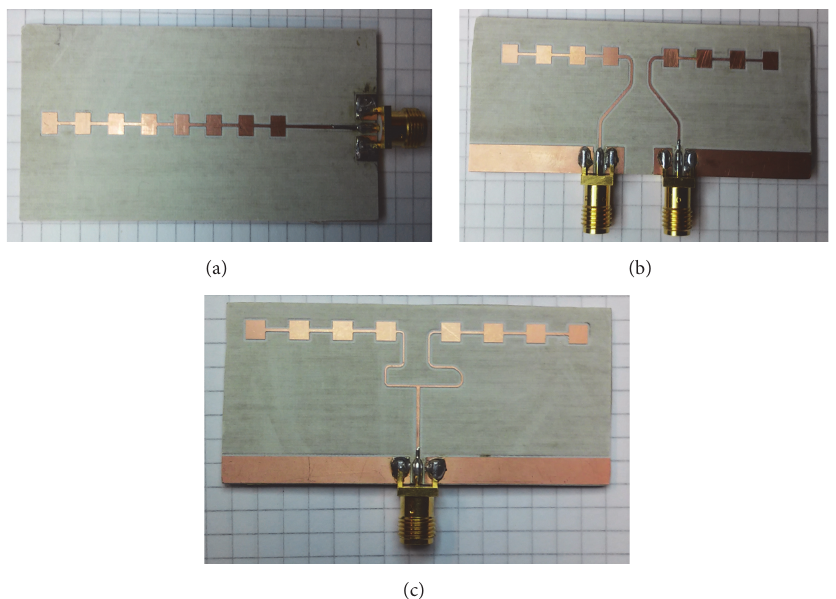
Figure 10: Serial array with 8 patches (a); transmitting (b) and receiving (c) antennas.